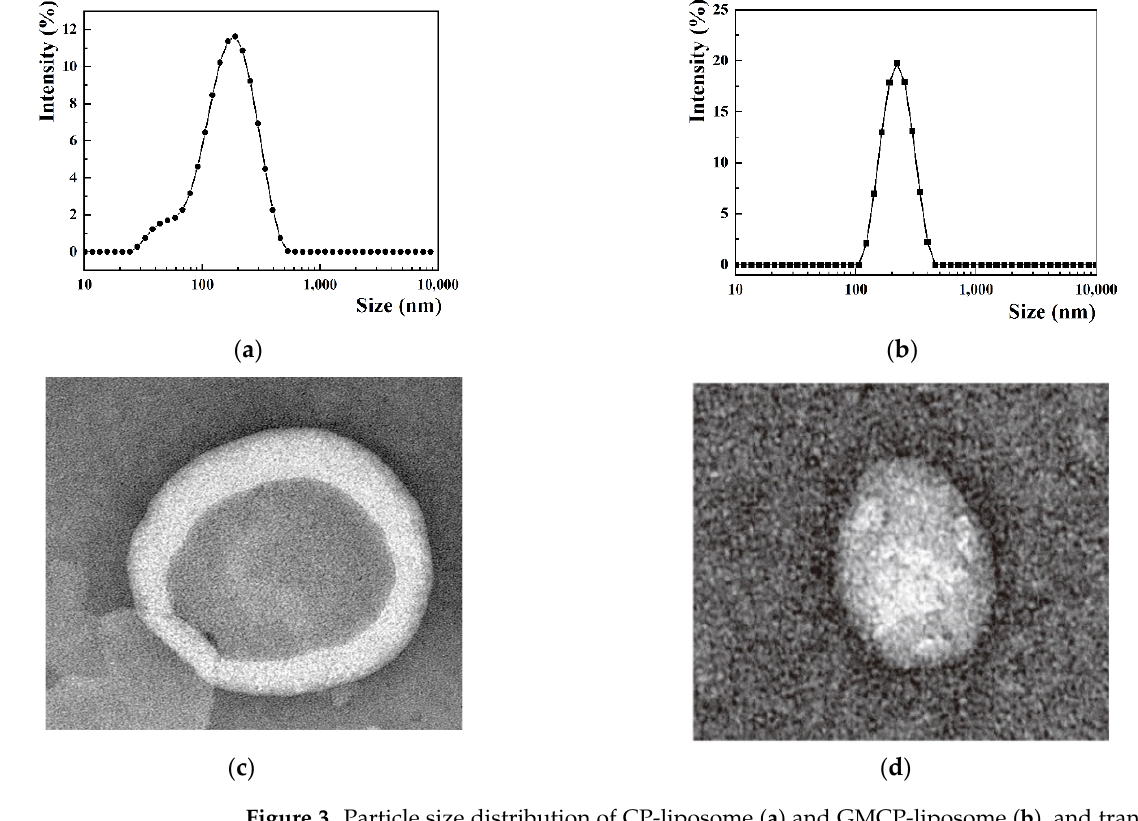
Figure 3. Particle size distribution of CP-liposome ( a ) and GMCP-liposome ( b ), and transmission electron microscopy images of CP-liposome ( c ) and GMCP-liposome ( d ). Table 1. IC 50 values (µg/)mL of free CBD, CP-liposome, and GMCP-liposome against different tu- mor cell lines after 72 h incubation (n = 5).